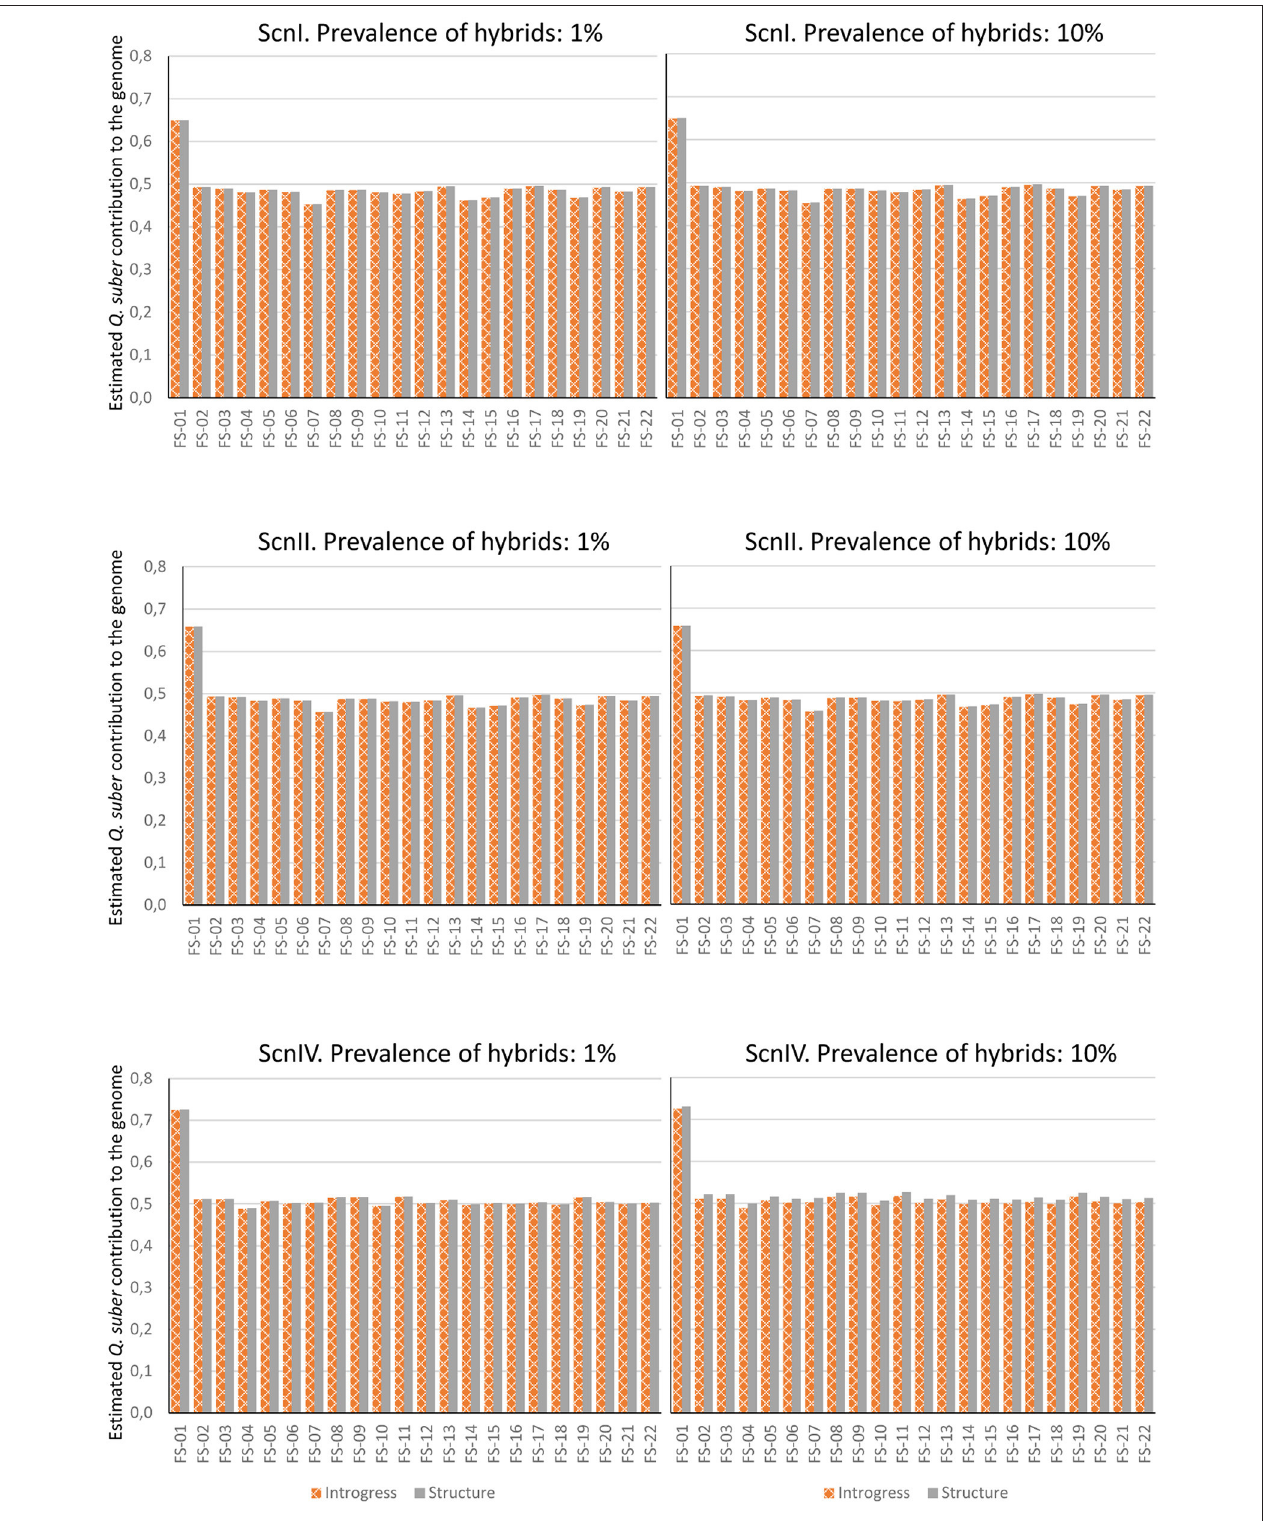
FIGURE 7 | Contribution of Q. suber to the genome of adult hybrids under each scenario, estimated by means of STRUCTURE ’s qs and Hybrid Index of INTROGRESS , with 1% and 10% of hybrids.